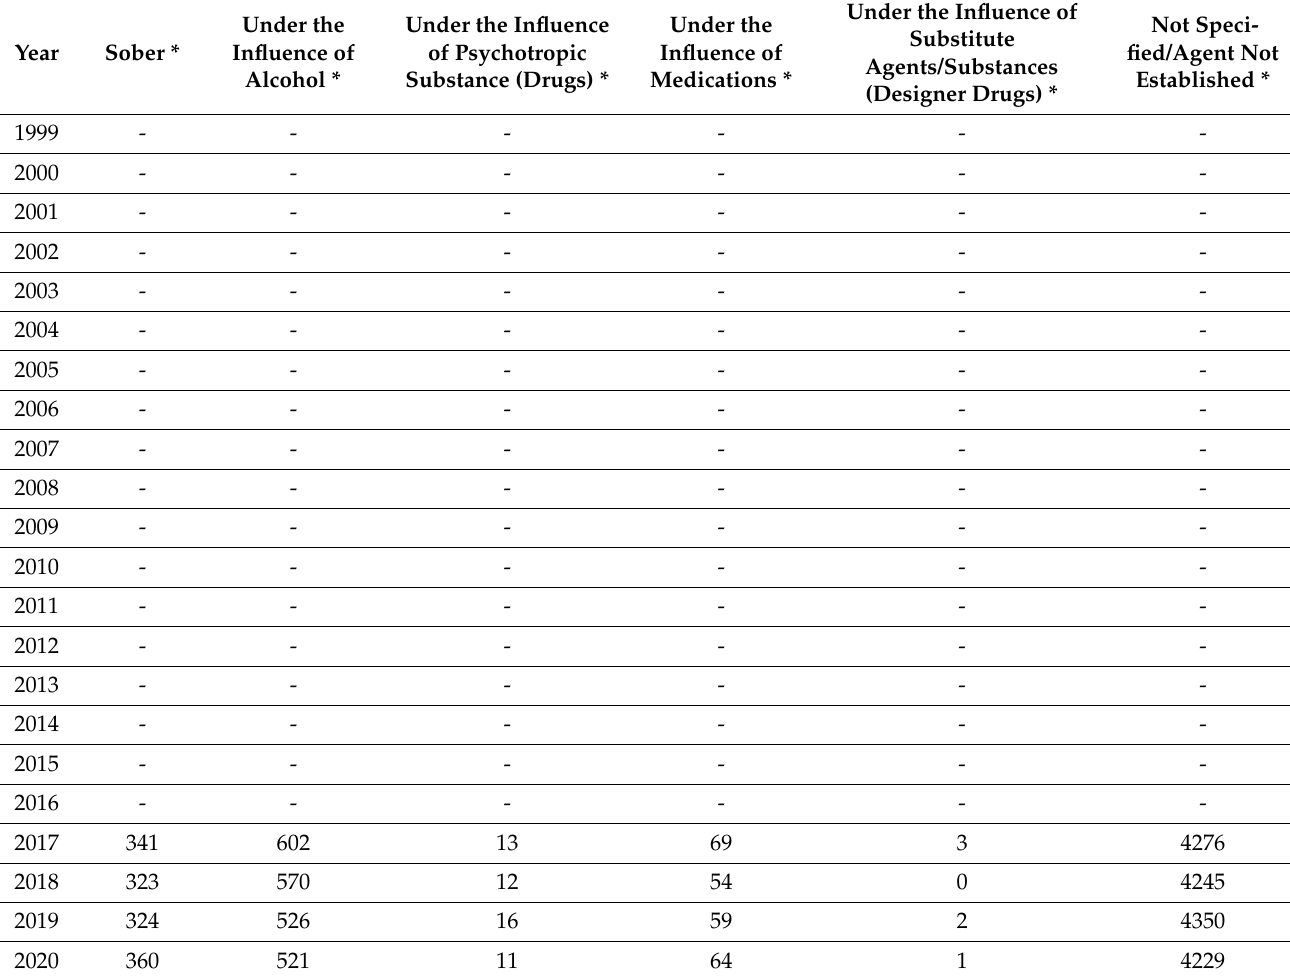
Table 4. Suicide depending on the state of consciousness (source: own study based on data by GPHP).